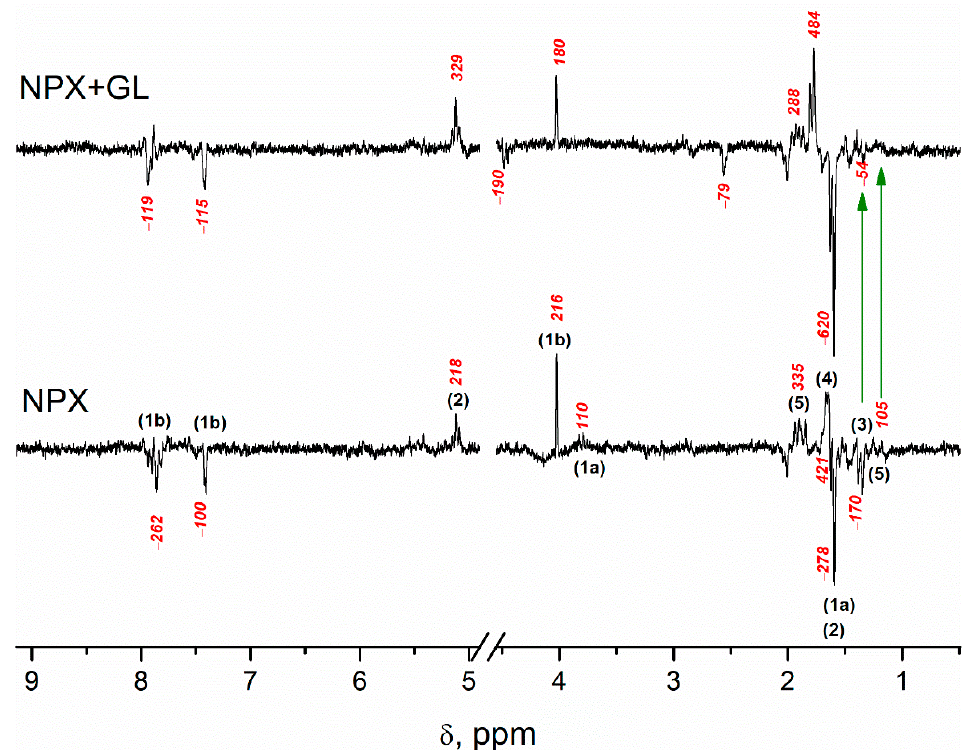
Figure 3. 1 H TR-CIDNP spectra of 4.3 mM NPX (bottom) and an equimolar mixture of NPX and GL (top) in acetonitrile: water (1:2) solution with integrals of signals (red). Assignment of the signals (black) corresponds to the structures of product numbering in Scheme 1. The delay time between the laser pulse and NMR detection pulse is 0 for both cases. Green arrows show the most pronounced effect of GL on the bulk products.